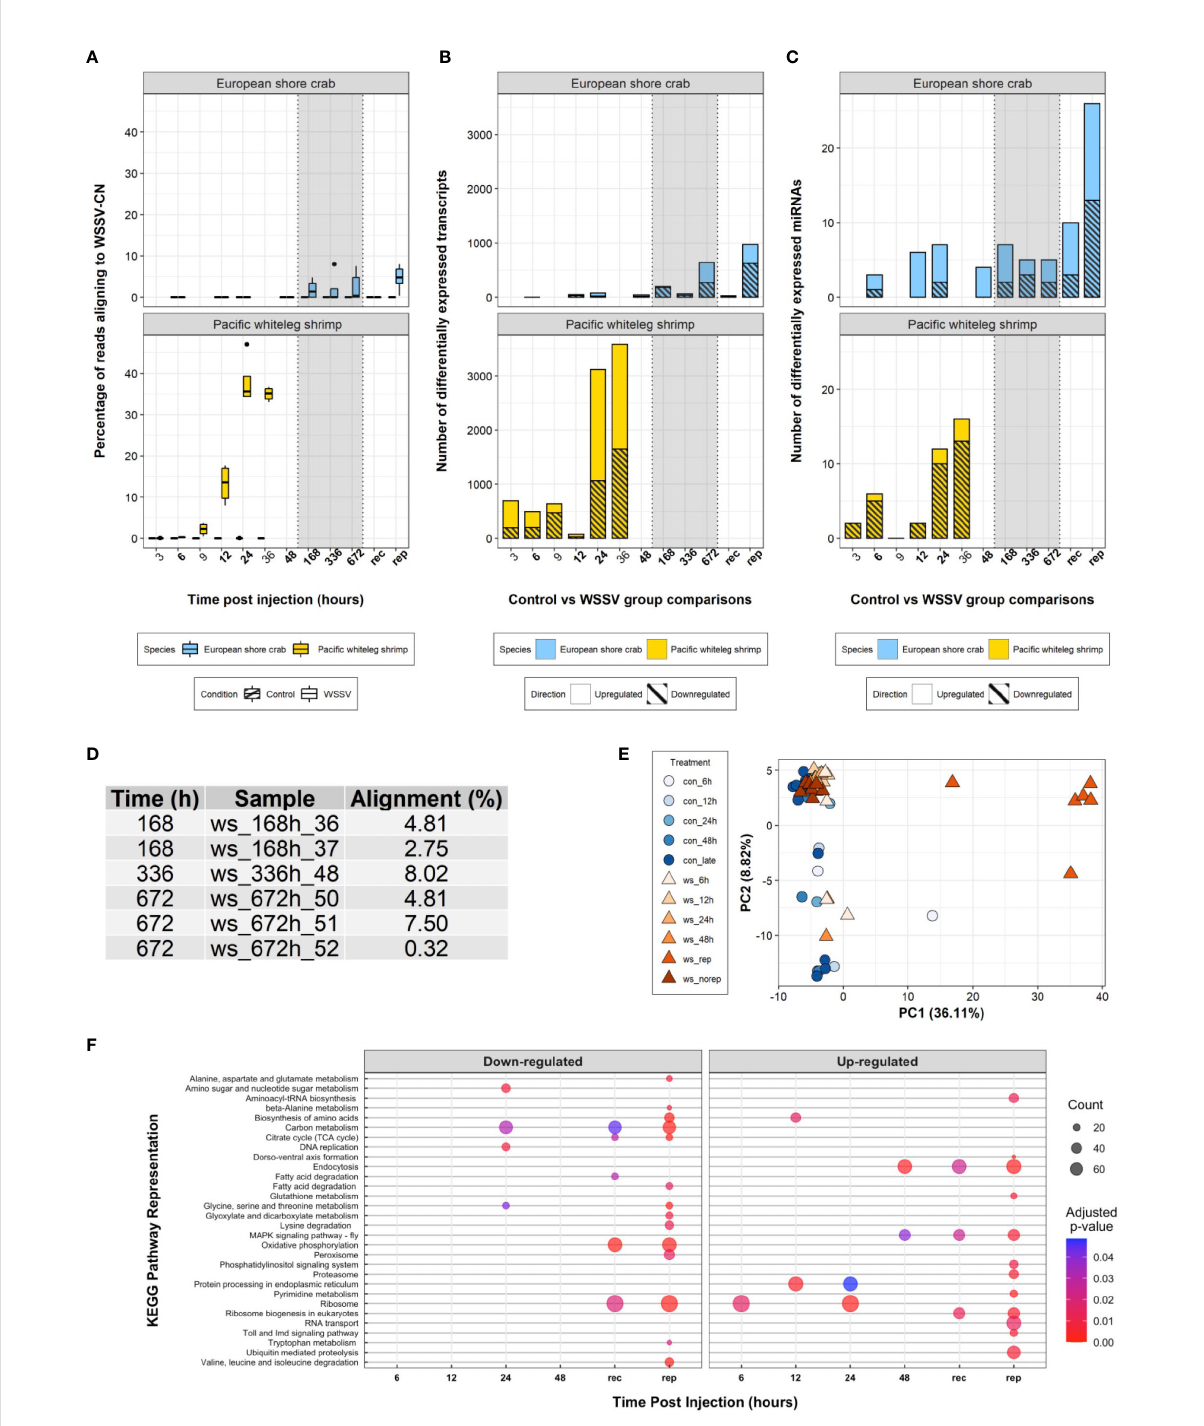
FIGURE 2 Transcriptome analysis. (A) Boxplot of the percentage of processed sequencing reads aligning to the WSSV-CN genome [GenBank Accession AF332093.3 (12)] over time in control and WSSV treatments. (B) A stacked bar plot of differentially expressed transcripts over time following WSSV injection in both C. maenas and P. vannamei . (C) A stacked bar plot of differentially expressed miRNAs over time following injection in both C. maenas and P. vannamei . (D) Percentage of processed sequencing reads aligning to the WSSV-CN genome in crabs displaying evidence for WSSV replication. (E) Principal component analysis of differentially expressed C. maenas transcripts in response to WSSV injection demonstrating separation of crabs displaying evidence for WSSV replication according to principal component 1. (F) Bubble plot of KEGG pathways up- and down-regulated over time in C. maenas in response to WSSV injection where point size represented the number of transcripts identi fi ed in the KEGG pathway and colour represents the adjusted p-value for